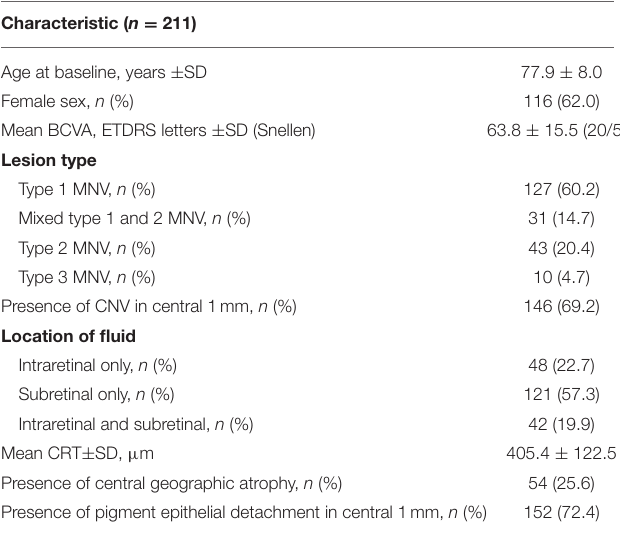
TABLE 1 | Baseline